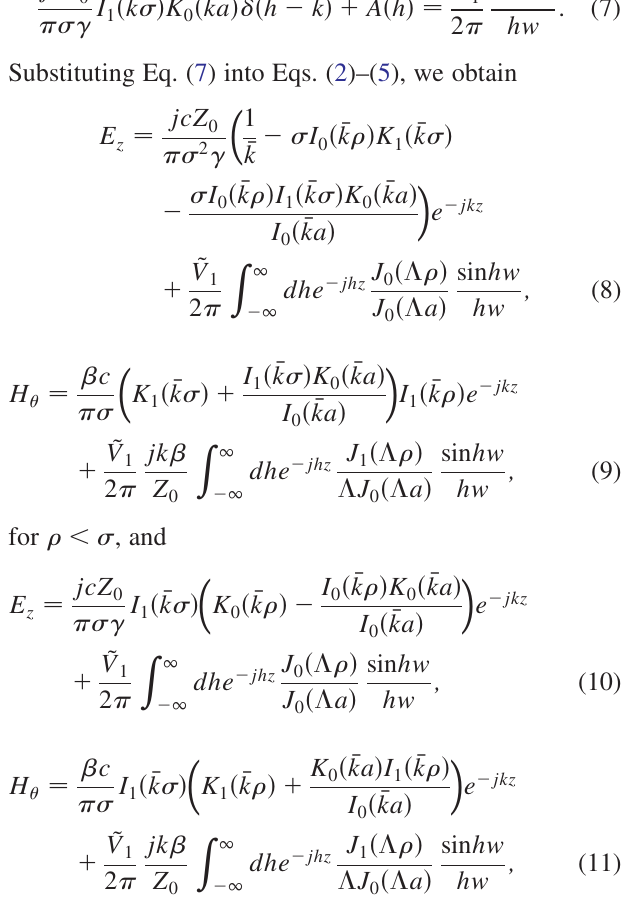
FIG. 1. (Color) The insert (denoted by green objects), which is cylindrical coordinate system ð (cid:2); (cid:3); z Þ